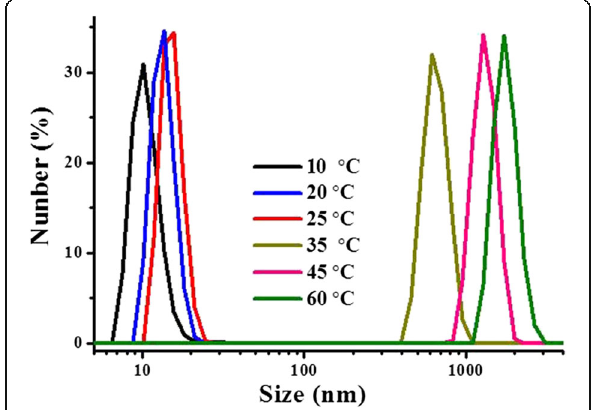
Fig. 4 Diameter of thermoresponsive P(OEGDA-MAA) hydrogel in aqueous dispersion (1 mg/mL, pH 1.0) at different